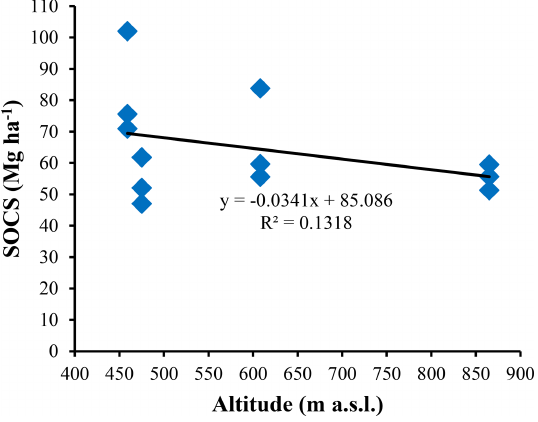
Figure 4. Plots of the soil organic carbon stock (SOCS) versus al- titudinal gradient in the study area.